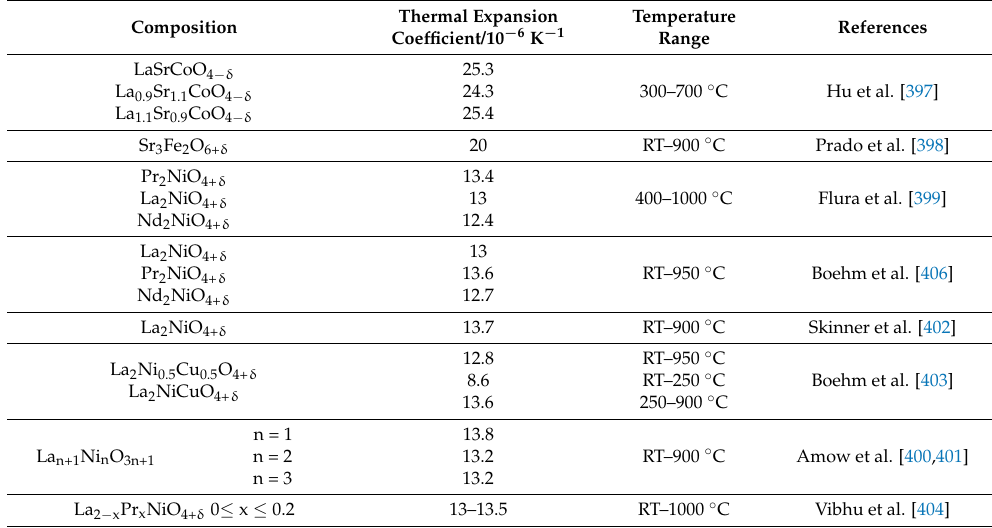
Table 13. Linear thermal expansion coefficients of Ruddlesden-Popper structured